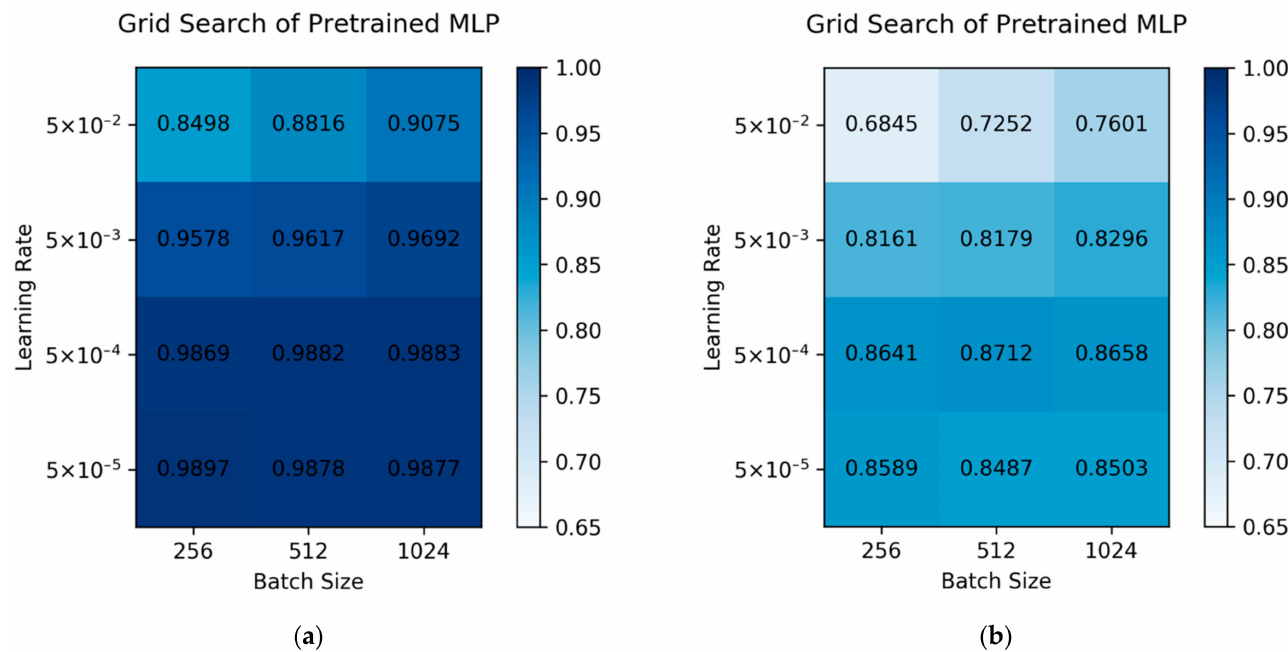
Figure 1. ( a ) Grid search for the pre-trained network over a fivefold cross-validation method. ( b ) Grid search for the pre-trained network over the intersection of the COCONUT dataset and the ChEMBL dataset. The values in the grids are the mean AUROC scores. The higher scores our models have achieved are colored with a deeper blue background. A score of 0.65 is defined as a baseline of the transparent